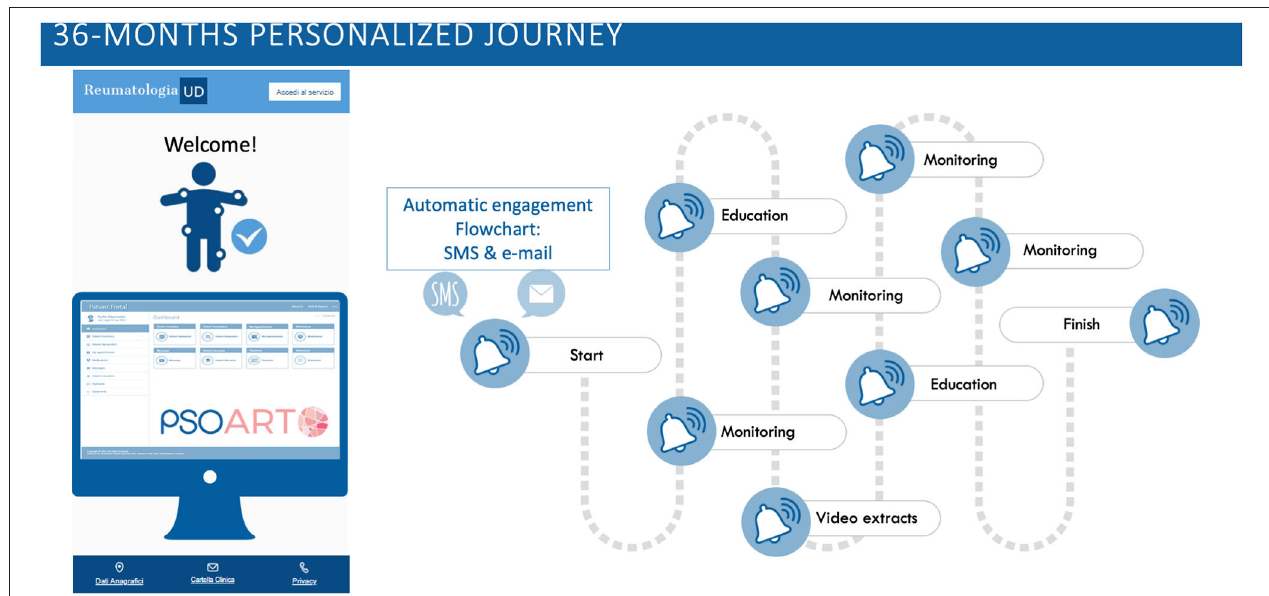
FIGURE 2 | PSOART personalized journey. The 36-months patient-targeted journey is hereby represented. The PSOART platform uses an automatic email/sms communication system targeted on the patient. It offers encouraging goal, such as educational material and video extracts, as well as “alert” for the rheumatologic center